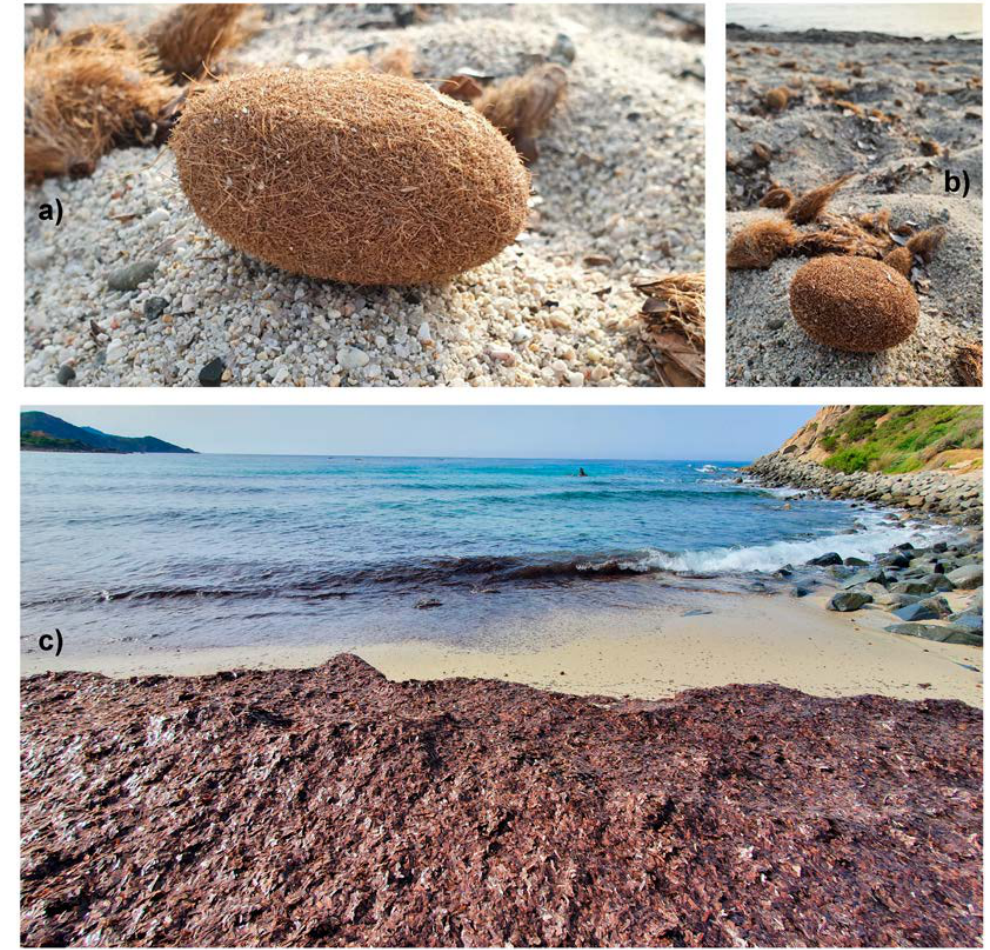
Figure 1. Examples of Posidonia Balls ( a , b ) and “banquettes” on the beach ( c ). Posidonia oceanica is an aquatic plant endemic to the Mediterranean Sea, and it belongs to the Posidoniacee family (Monocotyledonous angiosperms). Posidonia oceanica meadows occupy a surface area between 2.5 and 5 million hectares [11] and perform important eco- logical functions in the Mediterranean Sea, not only for biodiversity conservation but also for the mitigation of climate change, thanks to their role in carbon sequestration [12,13] and their ability to trap microplastics [14]. In the last few decades, there has been a wide- spread regression (from 13% to 50% [15]) of the meadows in Mediterranean coastal wa- ters. Therefore, in view of their important ecological role, Posidonia oceanica meadows have fied as a Priority Habitat and included as of “Least Concern” on the Red List of the Inter- national Union for Conservation of Nature (IUCN)